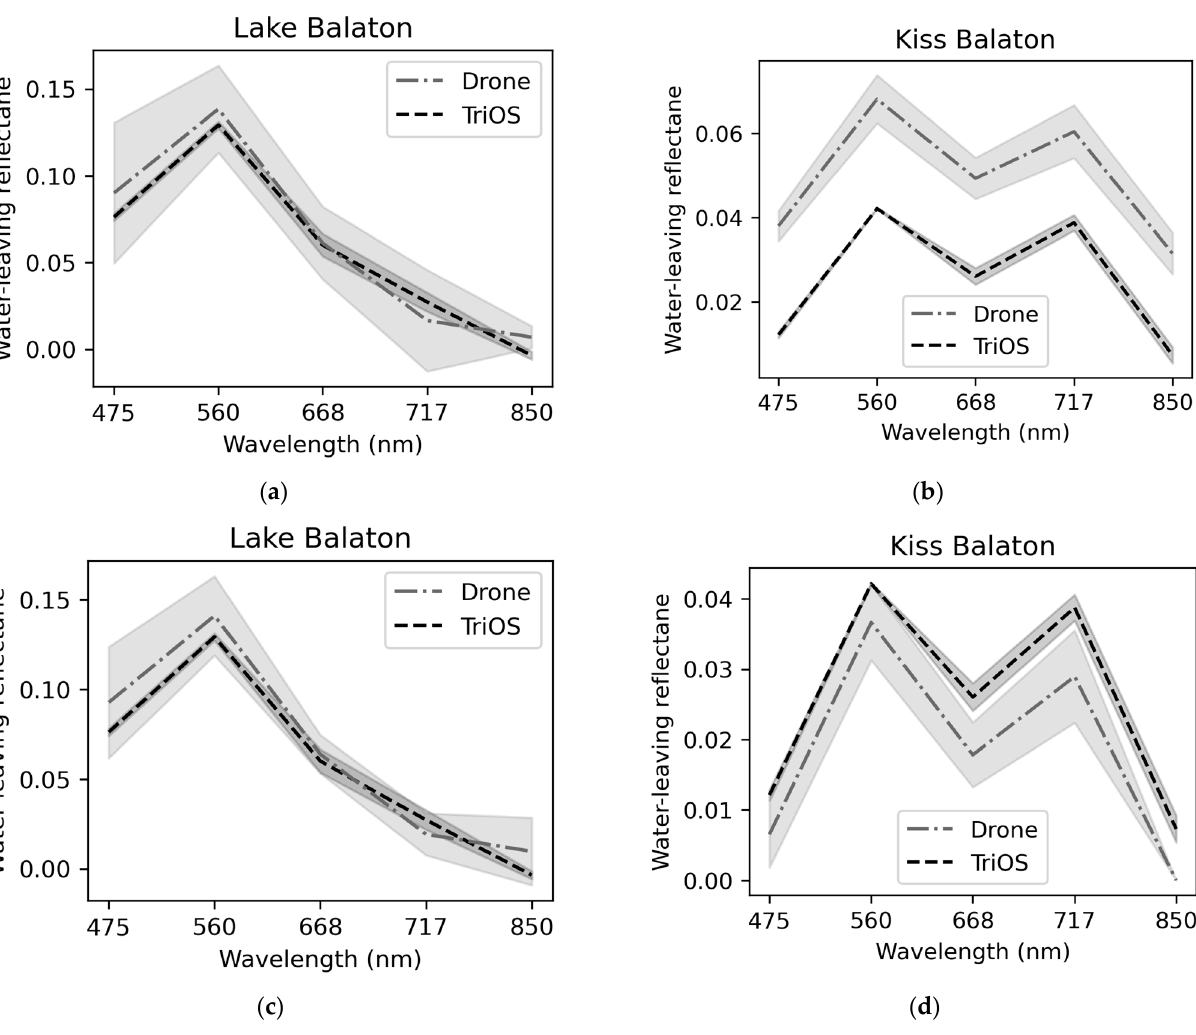
Figure 3. Mean Water-Leaving Reflectance of Drone (grey) and TriOS Ramses (black) data plotted for two different flights at Lake Balaton (Lake Balaton and Kiss Balaton). The upper plots ( a , b ) show the reflectance without RedEdge-NIR subtraction. The lower plots ( c , d ) show the reflectance with RedEdge-NIR subtraction.